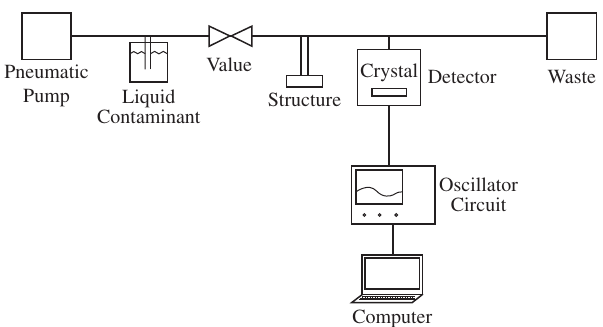
Figure 2. Schematic diagram for the experimental setup used for QCM liquid